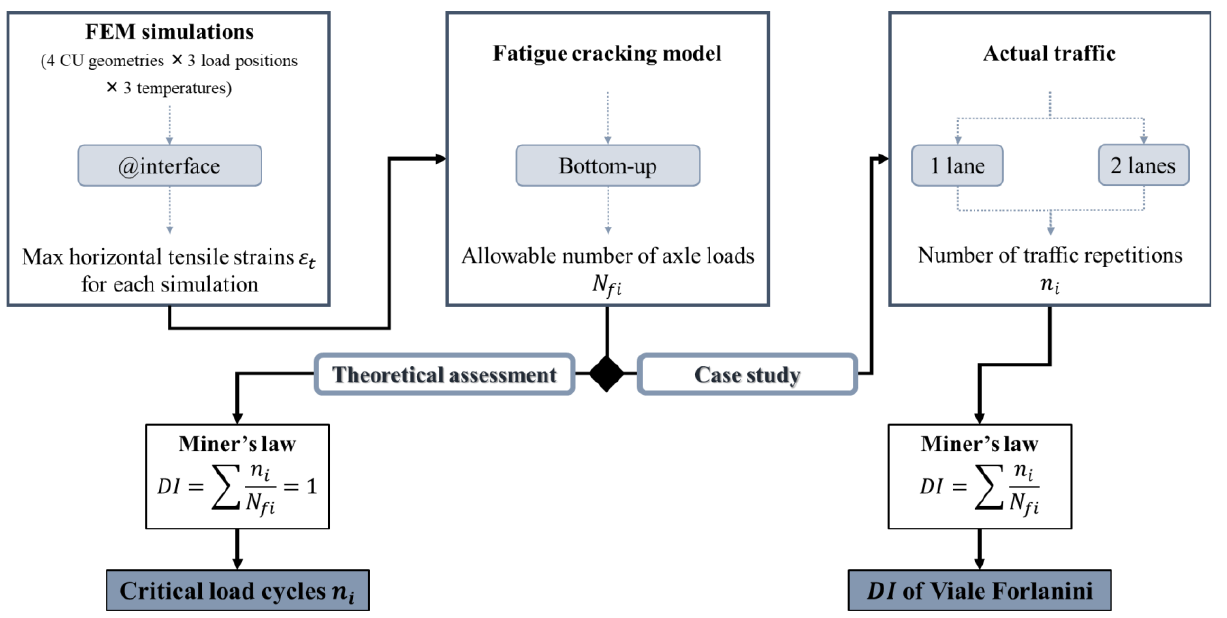
Figure 4. Experimental plan flow chart regarding fatigue assessment.